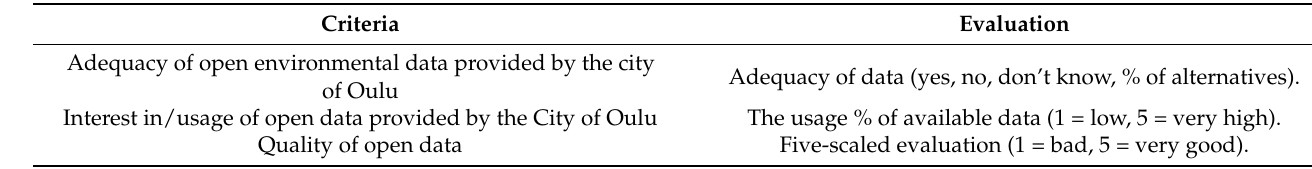
Table 4. Criteria to evaluate the quality of the open data. Criteria Evaluation of